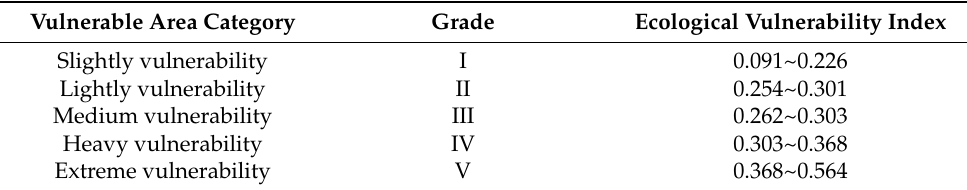
Table 4. Ecological vulnerability grading standard of